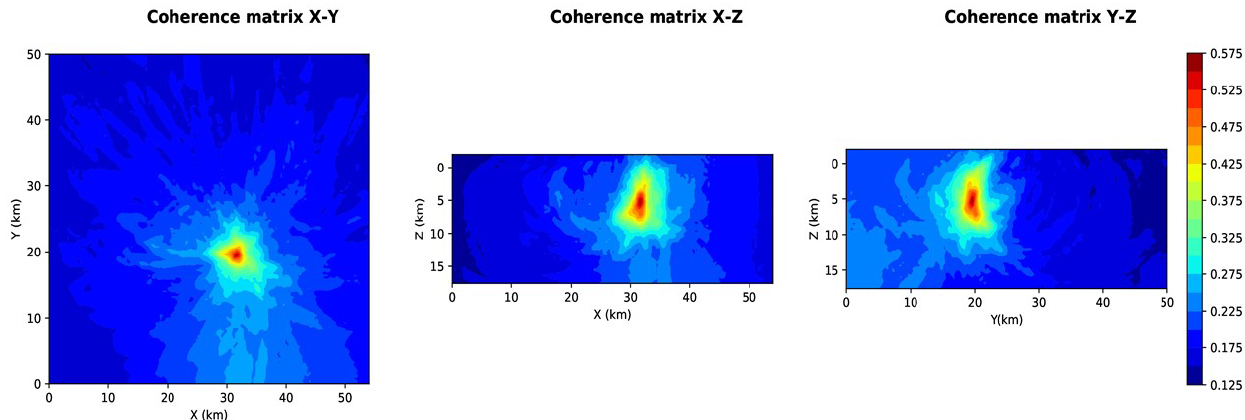
Figure 5. Example of coherence matrix related to M L 1 . 6 earthquake occurred on 30 December 2018. The coherence matrix XY is obtained by projecting, for each ( X , Y ) point, its maximum along Z direction (coherence matrices XZ and YZ are obtained in similar way). Coherence values are represented in color scale.